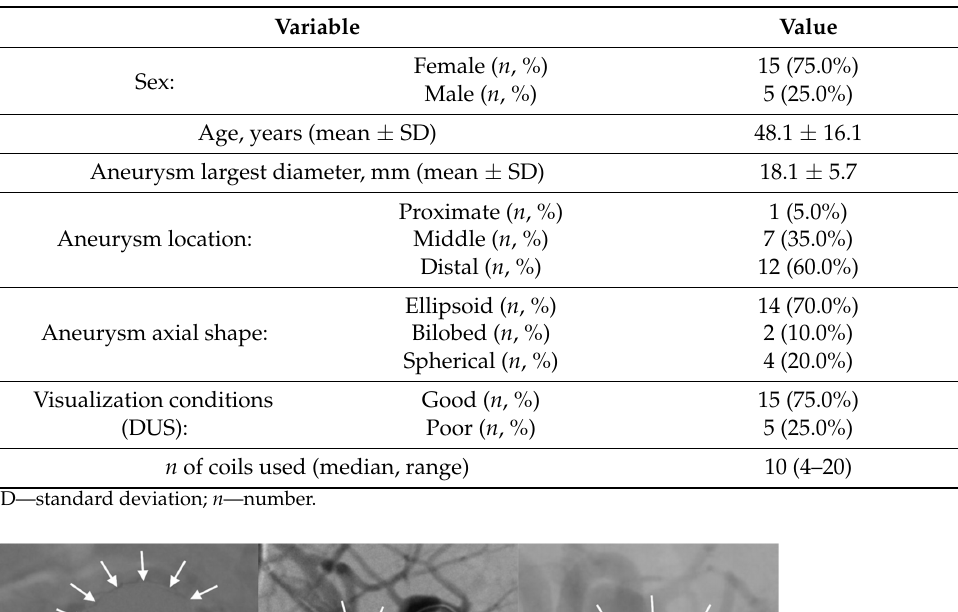
Table 1. Detailed patients’ and splenic artery aneurysms’ characteristics.